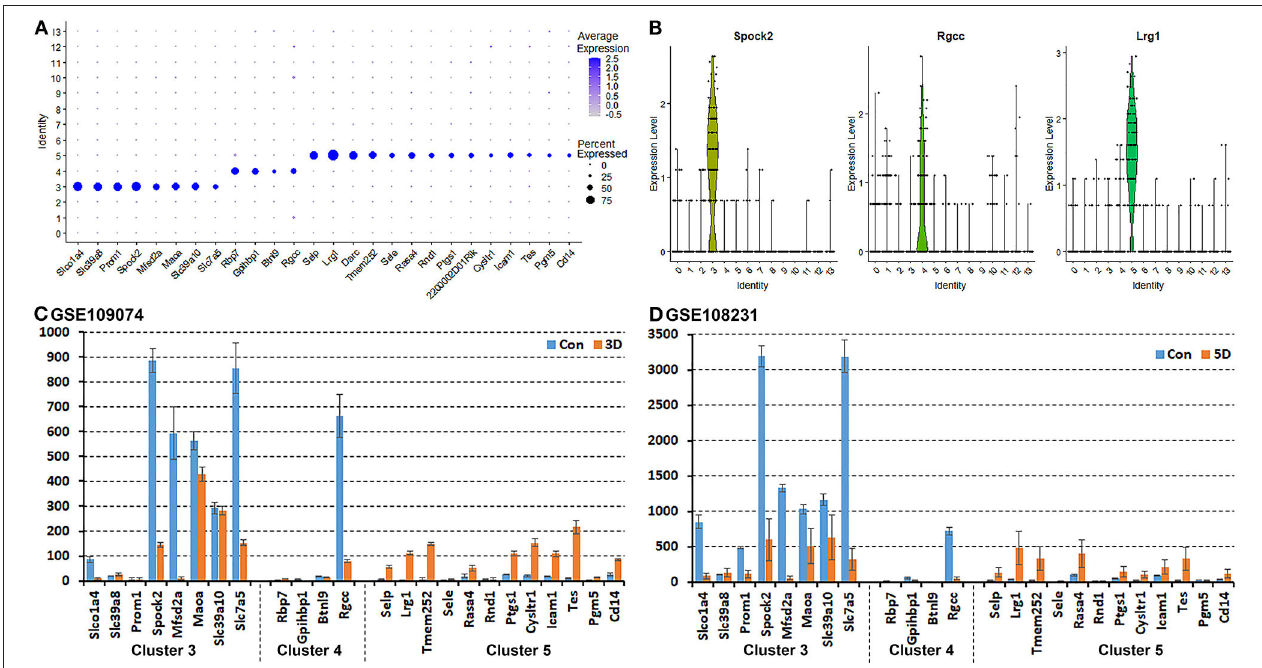
FIGURE 4 | Identification of DEGs unique to cluster 3, 4, and 5 in the intact mouse sciatic nerve. (A) Dot plot showing unique DEGs for cluster 3, 4, and 5 in the intact sciatic nerve. (B) Violin plot showing Spock2 expression in cluster 3, Rgcc in cluster 4 and Lrg1 in cluster 5 ECs in the intact sciatic nerve. (C) mRNA count showing the expression level of unique DEGs for cluster 3, 4, and 5 in intact sciatic nerve and in the distal nerve at day 3 post crush injury. (D) mRNA count showing the expression level of unique DEGs for cluster 3, 4, and 5 in intact sciatic nerve and in the distal nerve at day 5 post crush